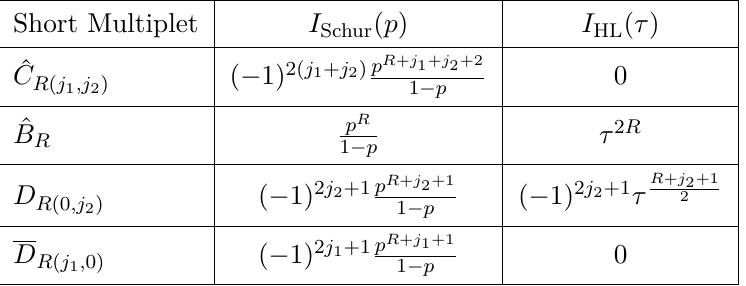
Table 1. Contributions from short multiplets to I Schur and I HL